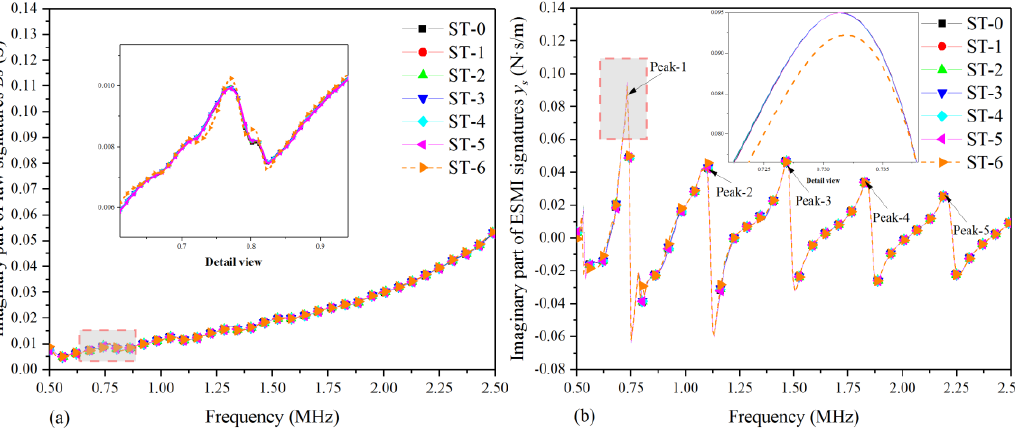
Figure 5. Imaginary part plot of raw and ESMI signatures: ( a ) B s ; ( b ) y s .